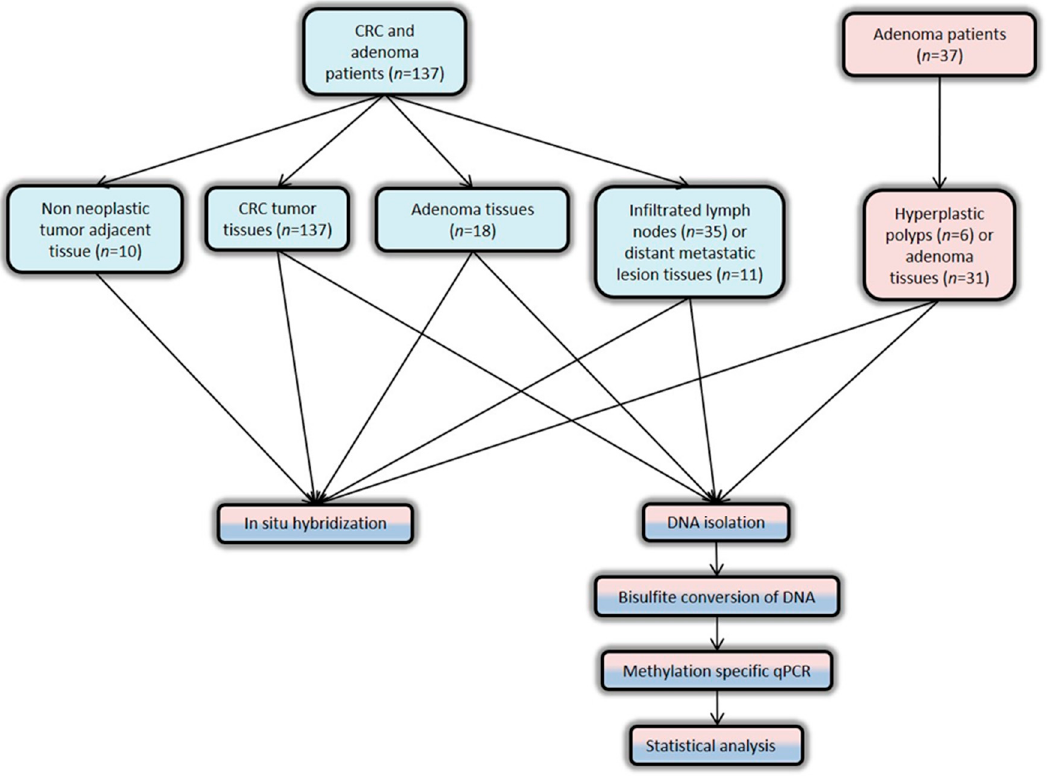
Figure 7. The workflow of the study.